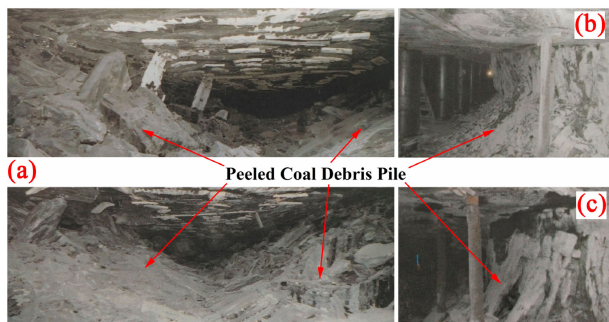
Figure 1. Examples of coal pillar spalling and coal fragment pilling up in the U.S. [2]: ( a ) failed pillars in the Cedar Grove coal seam: the coal fragments accumulated around the failed pillars and prevented them from totally crushing; ( b ) rib spalling of an airway pillar in the Hiawatha coal seam; and ( c ) rib spalling of yielding pillar in the Hiawatha coal seam.